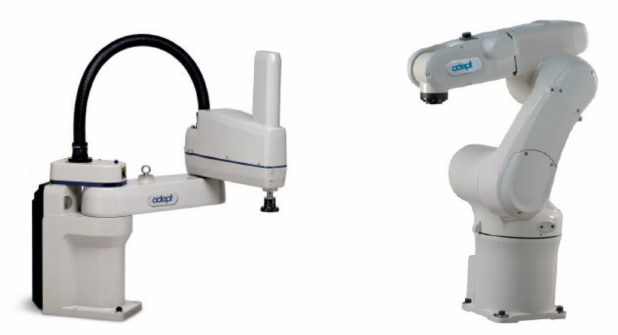
Figure 1. The Selective Compliance Assembly Robot Arm (SCARA) robot ( left ) and the articulated robot ( right ) exploited for the experimental validation of the Kinematic Directional Index (KDI)